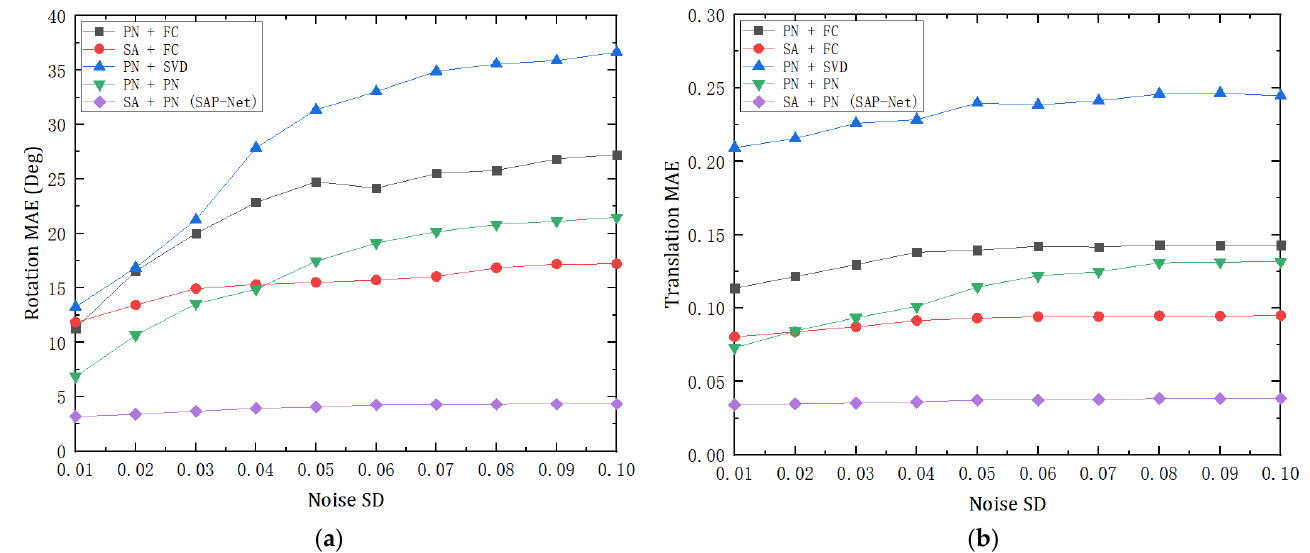
Figure 4. Registration results at different levels of Gaussian noise. ( a ) Mean absolute error (MAE) of rotation and ( b ) mean absolute error (MAE) of translation.